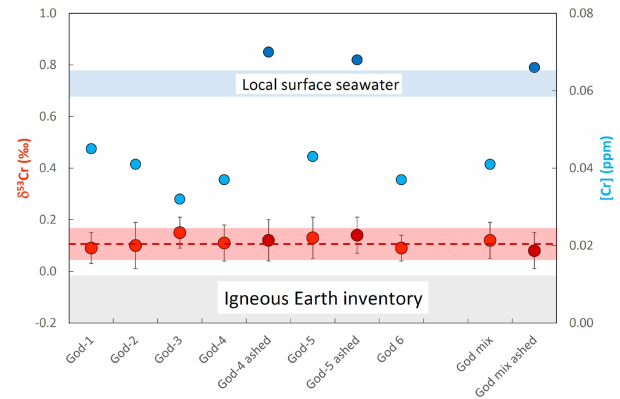
Figure 5. Plot showing the chromium concentrations ([Cr]; blue filled symbols) and chromium isotope compositions ( δ 53 Cr; red filled symbols) of various Mytilus edulis shells and of a shell mix- ture from Godhavn, Disko Bay, Greenland. The darker red and darker blue filled symbol mark analyses on incinerated shells, whereas the lighter colored respective symbols depict analyses from solely aqua-regia-dissolved shells. The light gray horizontal bar de- picts the igneous Earth inventory composition (Schoenberg et al., 2009), and the blue horizontal bar the local surface seawater com- position measured from this location (Paulukat et al., 2016). For details see